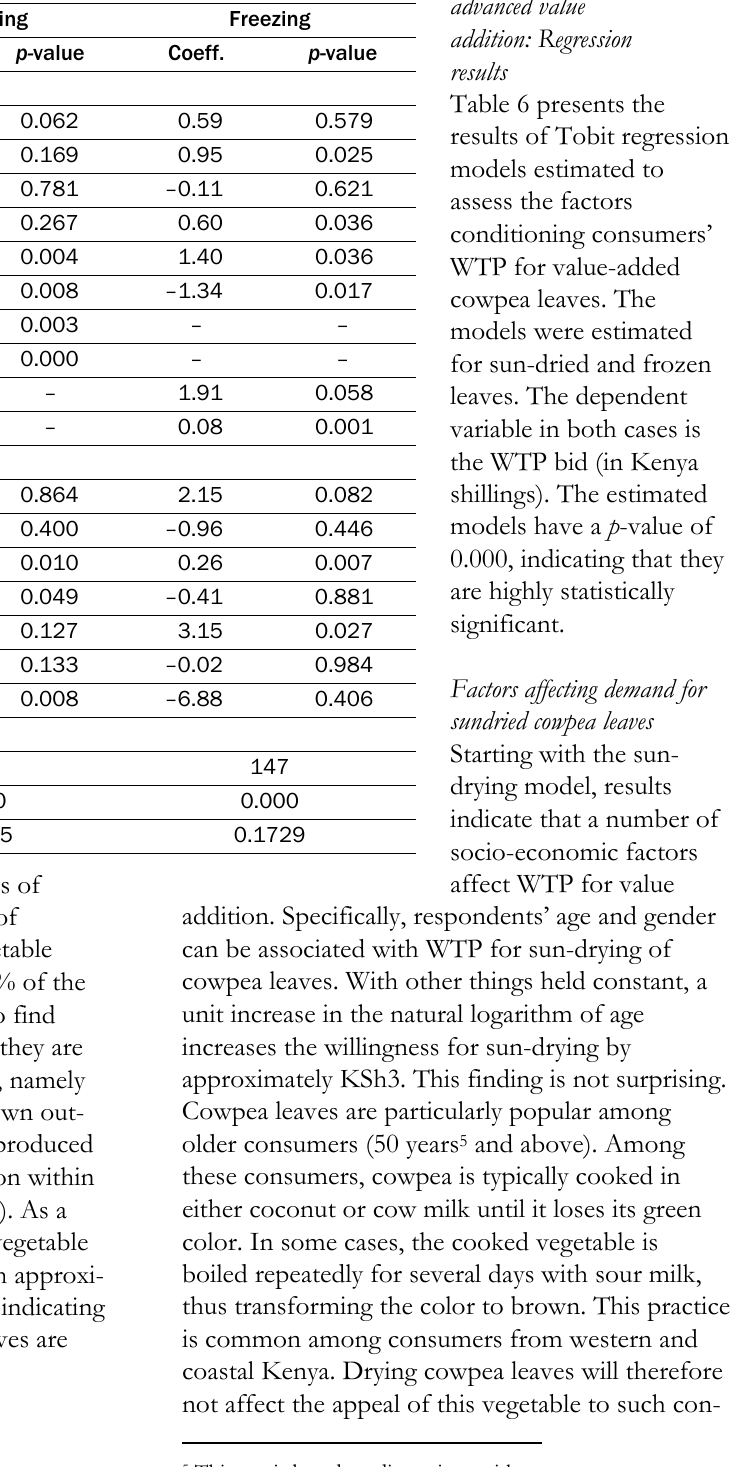
Table 6. Factors Affecting Willingness To Pay for Advanced Value-Addition Processes: Tobit Regression